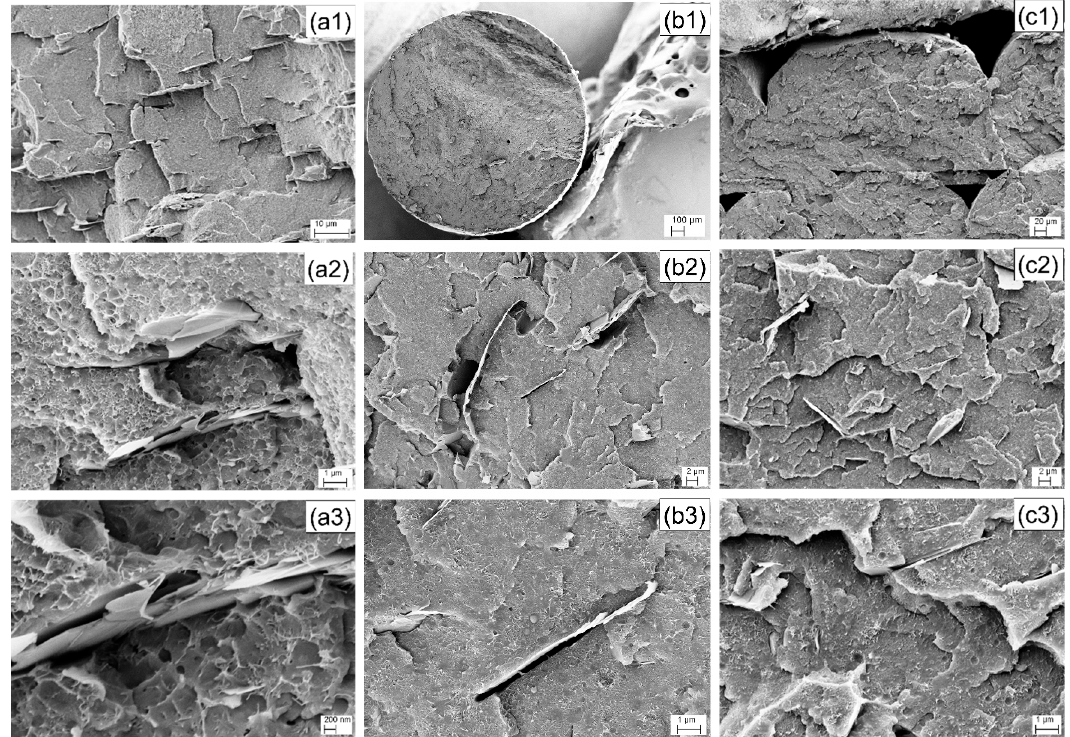
Figure 3. SEM micrographs at increasing magnification of GNP/CNT (50:50) nanocomposites produced by compression molding ( a1–a3 ), filaments ( b1–b3 ), and fused filament fabrication (FFF) horizontal concentric (HC) samples ( c1–c3 ).